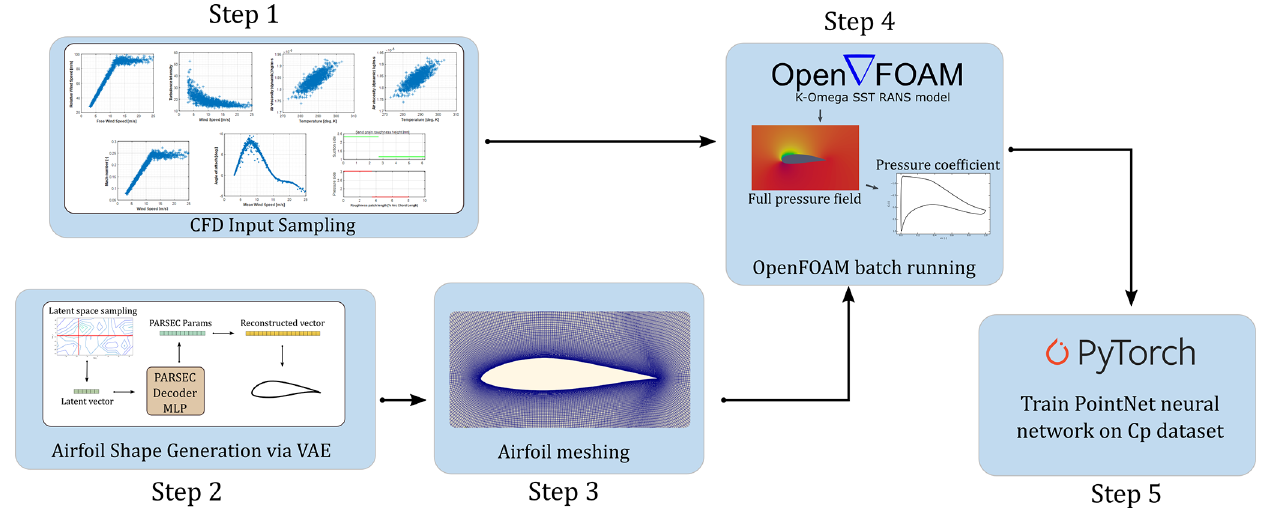
Figure 13. Overview of the proposed approach to simulate aerodynamic pressure coefficient data under diverse conditions of LEE, which are then used to train a neural network for diagnostics purposes.